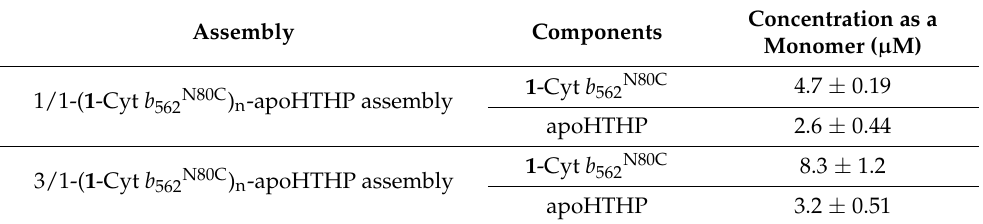
Figure 7. SDS-PAGE for protein concentration analysis. Lanes 1 and 8: 3/1-( 1 -Cyt b 562N80C ) n - apoHTHP assembly. Lanes 2 and 9: 3/1-( 1 -Cyt b 562N80C ) n -apoHTHP assembly. Lanes 3–7: 10 µ M, 8 µ M, 6 µ M, 4 µ M, and 2 µ M of HTHP in lanes 3, 4, 5, 6, 7, respectively. Lanes 10–16: 30 µ M, 25 µ M, 20 µ M, 15 µ M, 10 µ M, 5 µ M, and 2 µ M of 1 -Cyt b 562N80C in lanes 10, 11, 12, 13, 14, 15, and 16, respectively. Table 1. Concentration of protein components in the fractionated